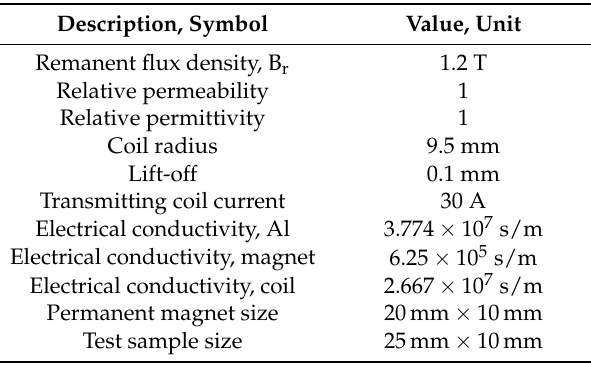
Table 1. Basic parameters for modeling EMAT.